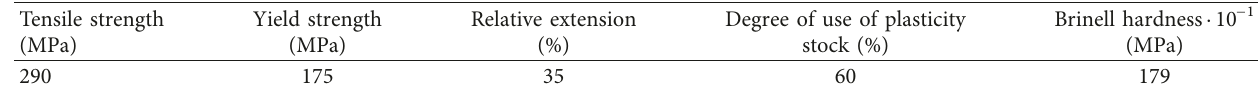
Table 2: Mechanical properties of the electrode tape at T � 20 ° S